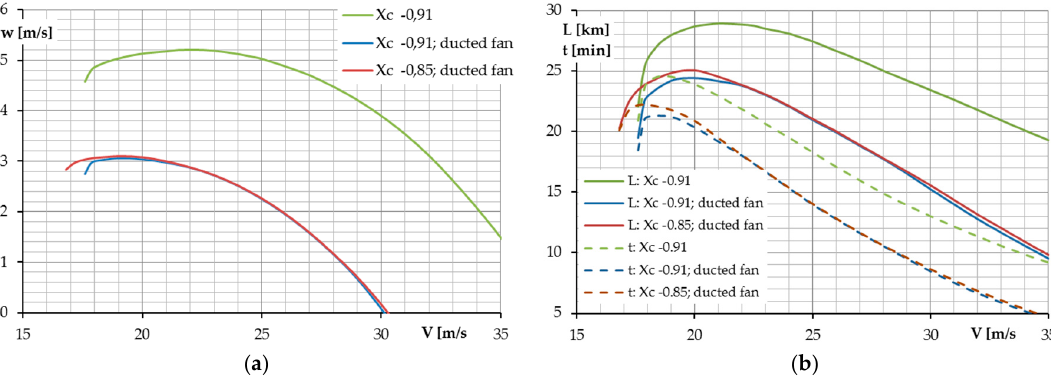
Figure 24. Variation in the airplane’s performance with the thrust vector position: ( a ) maximum climb rate; ( b ) range and flight duration with respect to the airspeed.